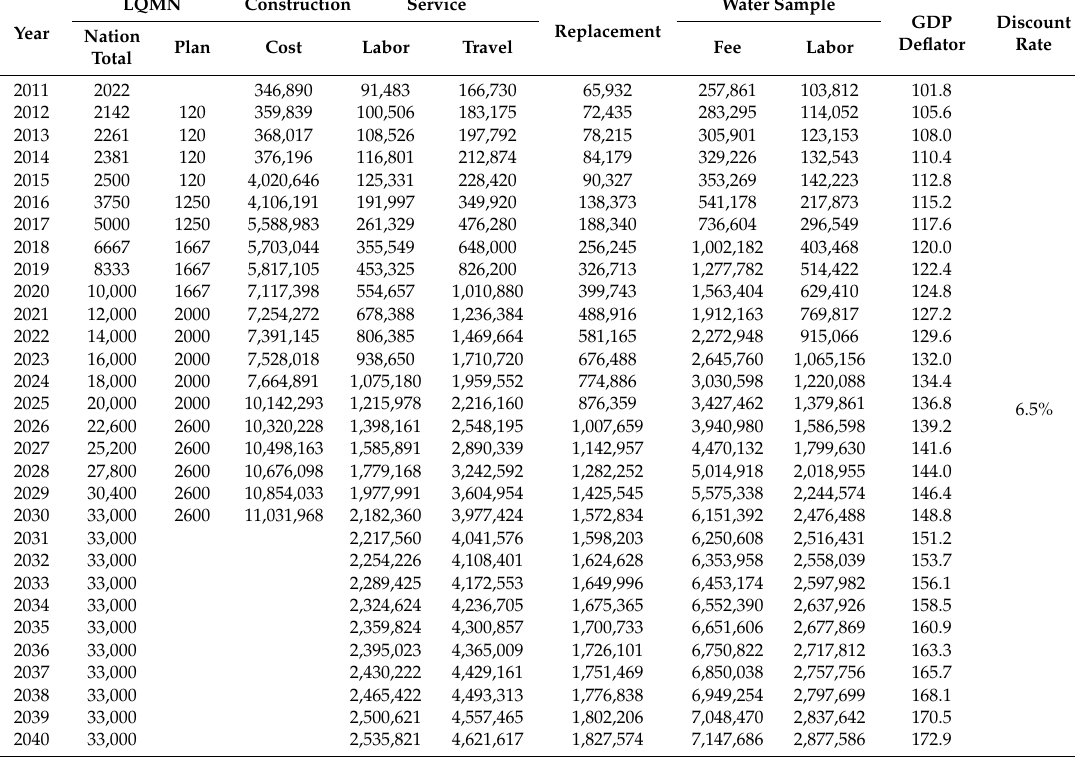
Table A6. Cost detail of the LQMN (unit: